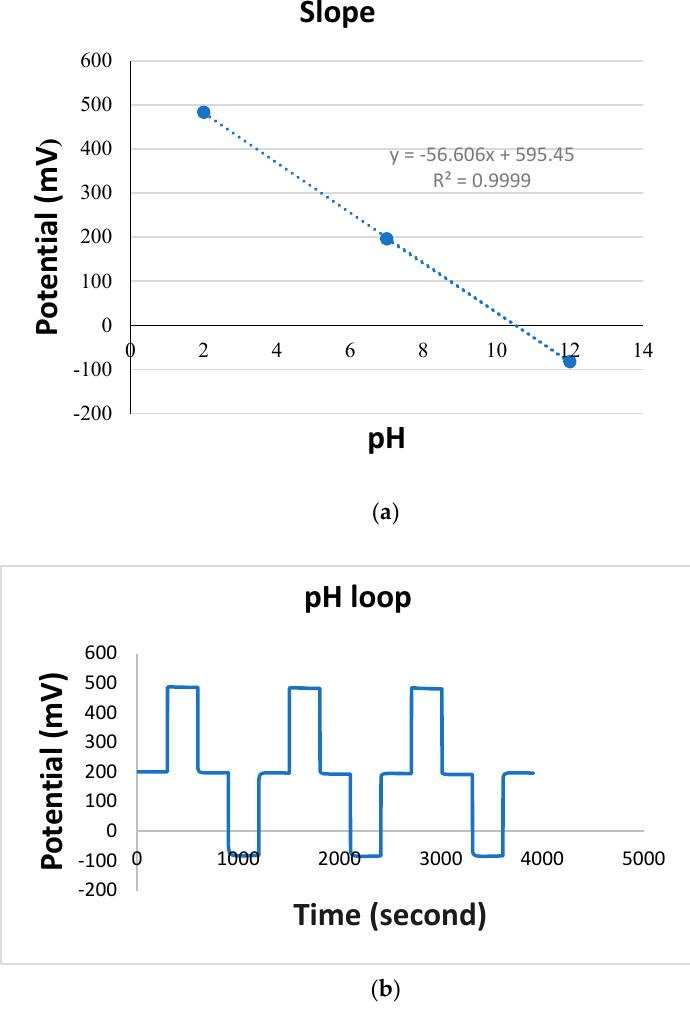
Figure 2. ( a ) Linear calibration plot for pH sensor from pH 2 to 12, ( b ) pH loop cycled 7-2-7-12-7 three times, using potential data versus time for TiN working electrode in pH 7 buffer vs. glass reference electrode.